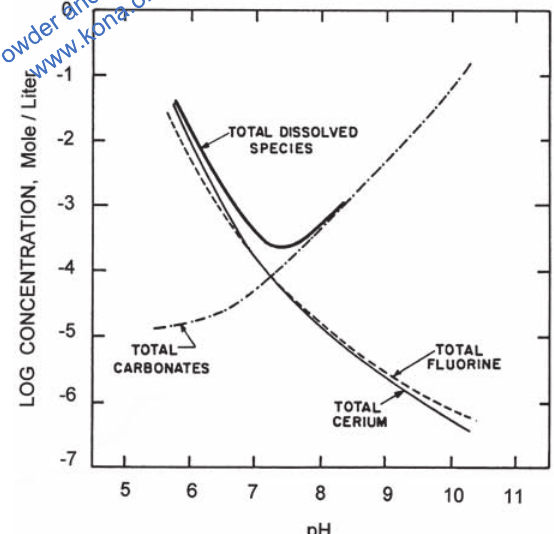
Fig. 3 The pH dependence of total cerium, total fluo- rine and total carbonate concentrations in aque- ous solutions in equilibrium with